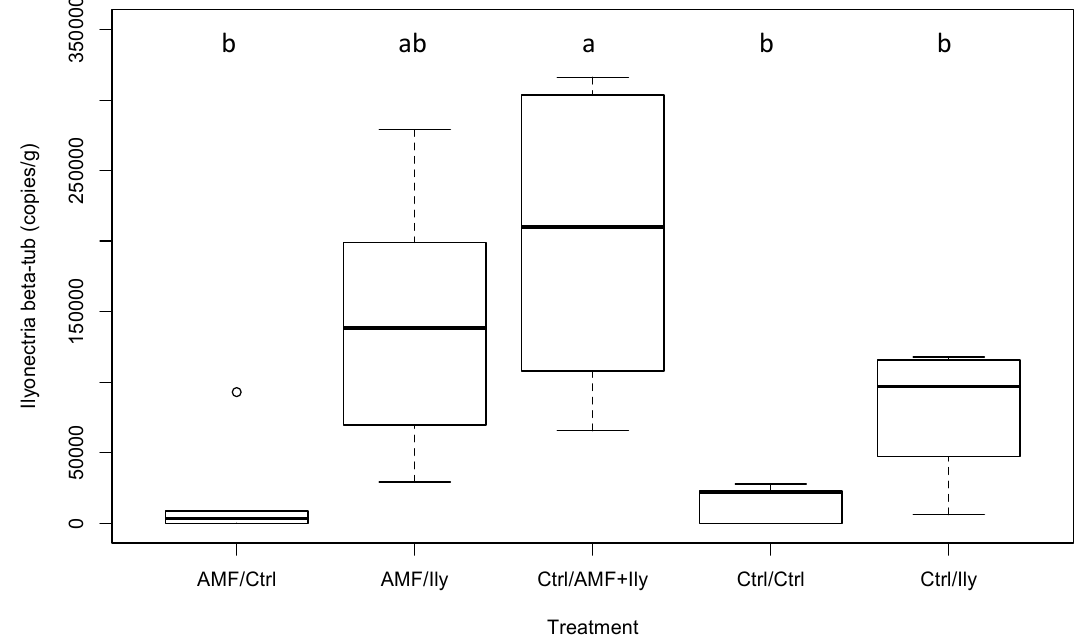
Figure 2. Ilyonectria beta-tubulin copy number per µ L in vine roots in response to inoculation treatments. Treatments: Ctrl / Ctrl, non-microbial control; Ctrl / Ily, pathogen control inoculated with only Ilyonectria ; AMF / Ctrl, mycorrhizal control, inoculated with only AM fungi; AMF / Ily, pre-inoculated with AM fungi followed later by Ilyonectria inoculation; Ctrl / AMF + Ily, co-inoculation with AM fungi and Ilyonectria . Values were obtained by digital droplet polymerase chain reaction and di ff erences determined using a one-way analysis of variance (ANOVA; F 5,41 = 5.586, p < 0.001), with di ff erences at p < 0.05 indicated by letters above bars (Tukey’s multiple comparison via general linear hypothesis).